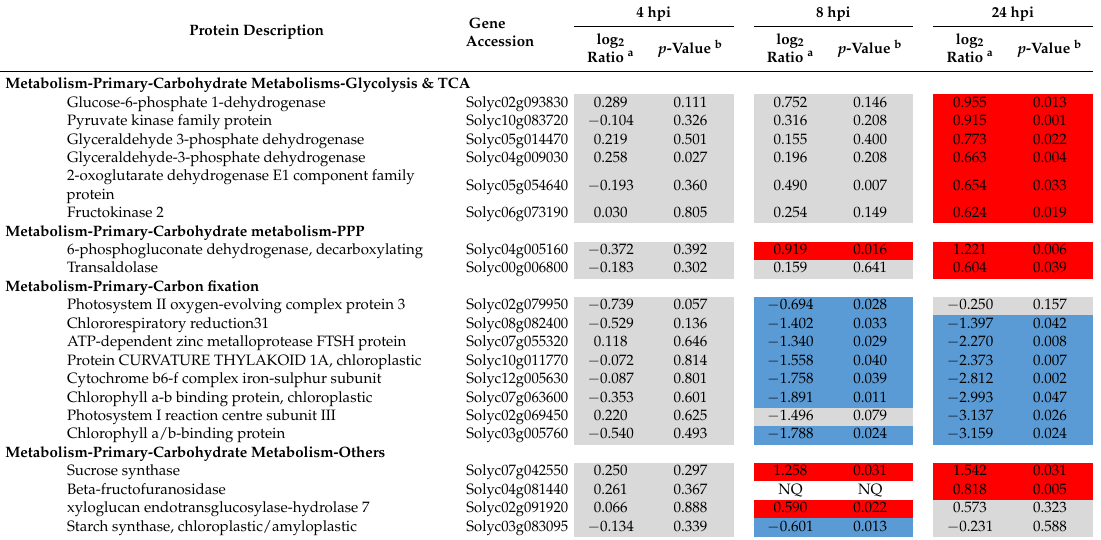
Table 3. Proteins involved in carbohydrate and energy metabolisms with significant change in abundance at 4, 8, 24, hpi of Pst DC3000.